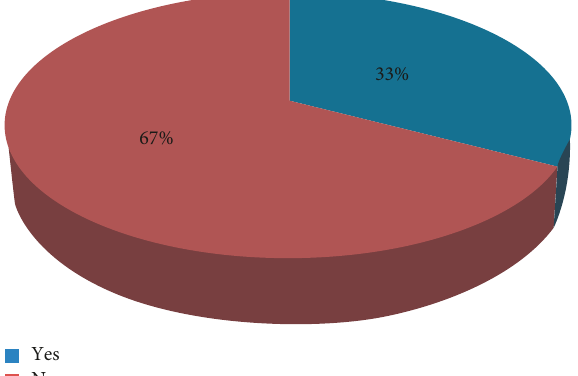
Figure 1: The incidence of postoperative pulmonary complications in patients who underwent abdominal surgery at public hospitals, Ethiopia.